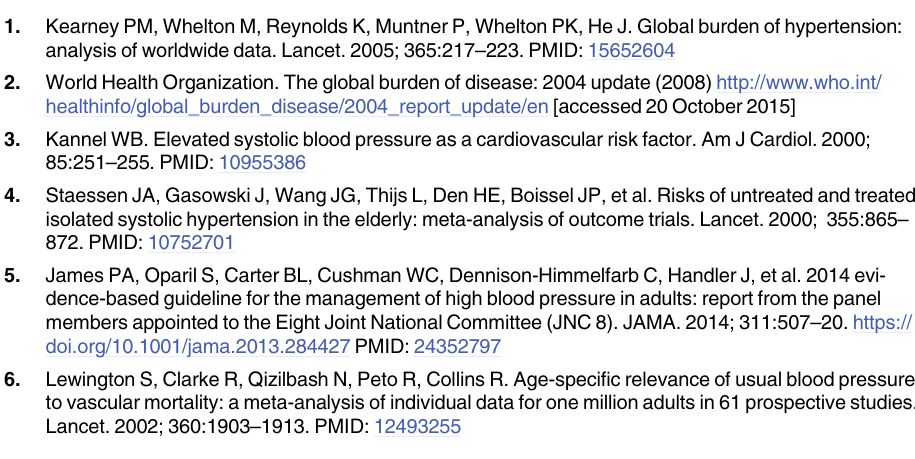
S3 Table. Decrease in pulse pressure in na ï ve patients with fimasartan alone through 1 year. S4 Table. Target clinic & home blood pressure achievement rate � † in nonelderly vs . elderly. Abbreviation: BP, blood pressure; JNC, Joint National Committee; ESC/ESH, European Soci- ety of Cardiology/European Society of Hypertension; ACC/AHA, American College of Cardi- ology/American Heart Association (AHA). S5 Table. Difference between pulse pressure reduction for 3 months and 1